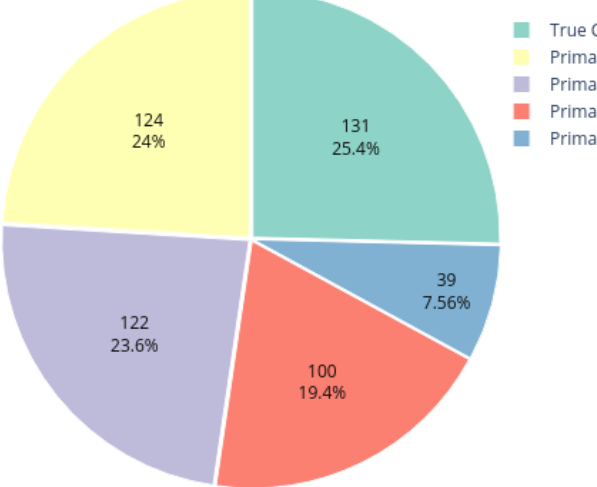
Figure 2. Dataset